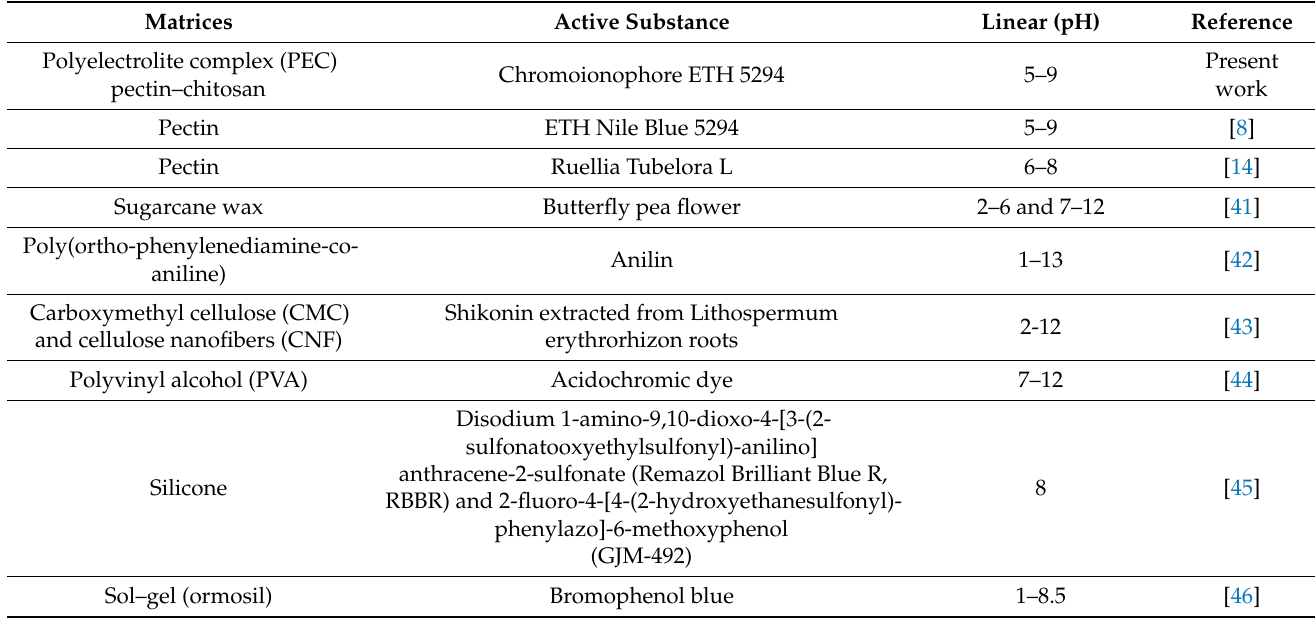
Table 2. Comparison of optical pH sensor measurements of fish freshness and